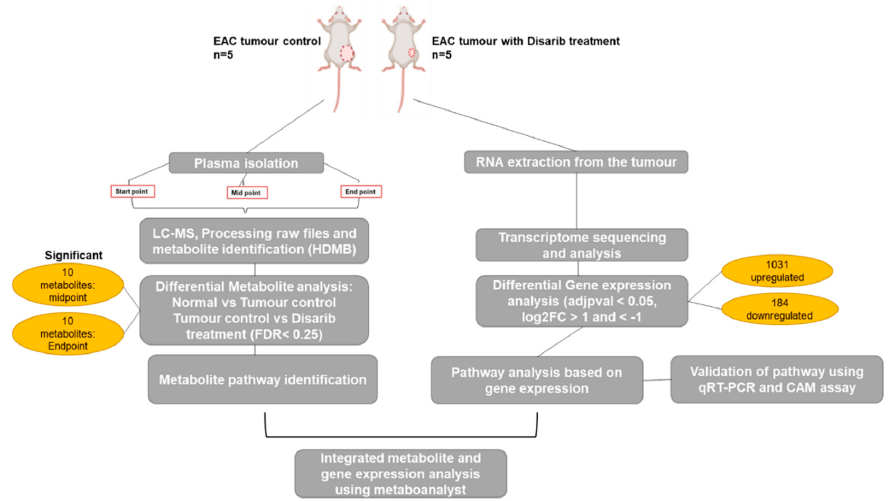
Figure 1. Experimental approach used for the study. Plasma was isolated from the blood of tumour control, Disarib treated and normal mice control, and Disarib treated at three different time points. Tumours from the control and treated animals were used to isolate RNA and perform transcriptome analysis. LC-MS was performed, and a metabolite profile was obtained for each sample. Transcrip- tome and metabolome data were further integrated, and significant pathways were obtained upon Disarib